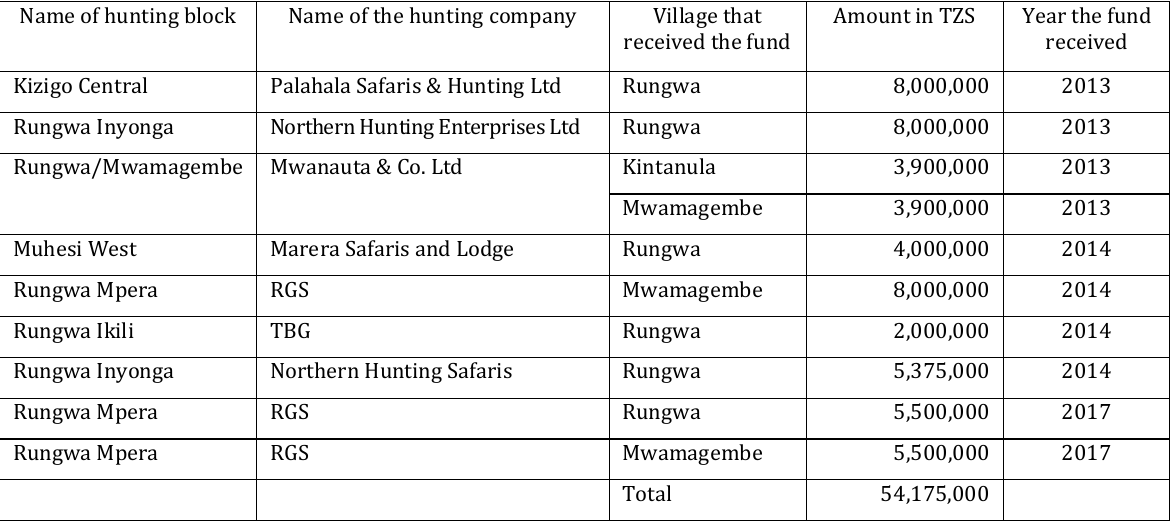
Table 4. Support provided by hunting companies (US$ 5000 per hunting block) for community initiated projects from the year 2013 to 2017 ( Source: Ministry of Natural Resources and Tourism, 2017) Name of hunting